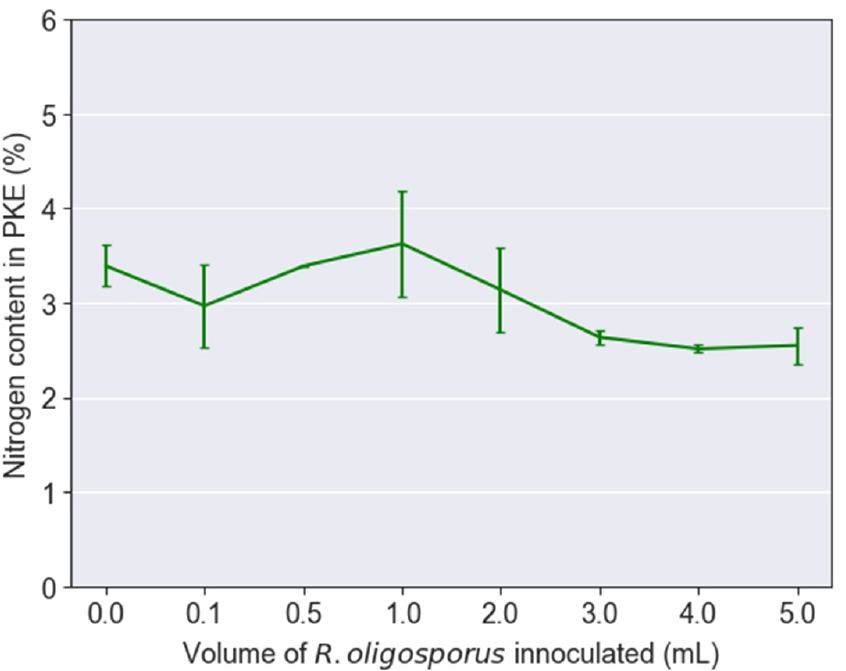
Figure 3. Nitrogen contents in palm kernel expeller residues after feeding to black soldier fly larvae. Interestingly, the ECD climbed from a low of 20.40% to 29.11% when the volume of R. oligosporus inoculated was increased from 1mL to 5mL. This occurred primarily because of the reduction in feed consumed, while the weight of biomass gained remained almost constant. When the volume of R. oligosporus inoculated was increased from 1mL to 5mL, the feed consumed by BSFL dropped gradually from around 6.24 g to 3.88 g ( p <